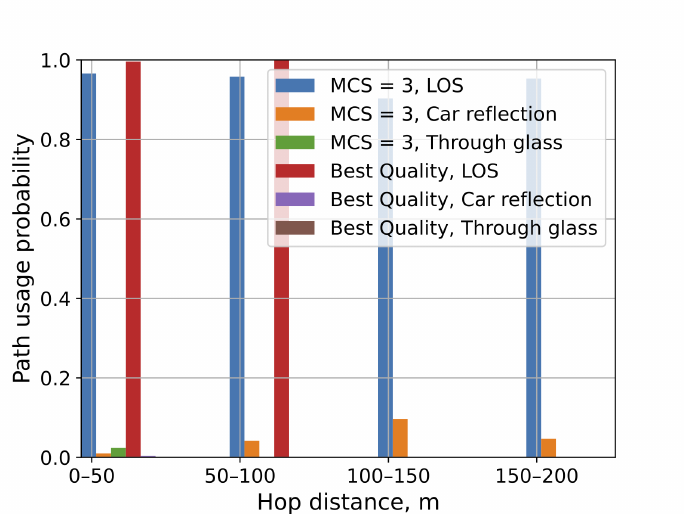
Figure 10. Histogram of the types of reflections used on different segments of the